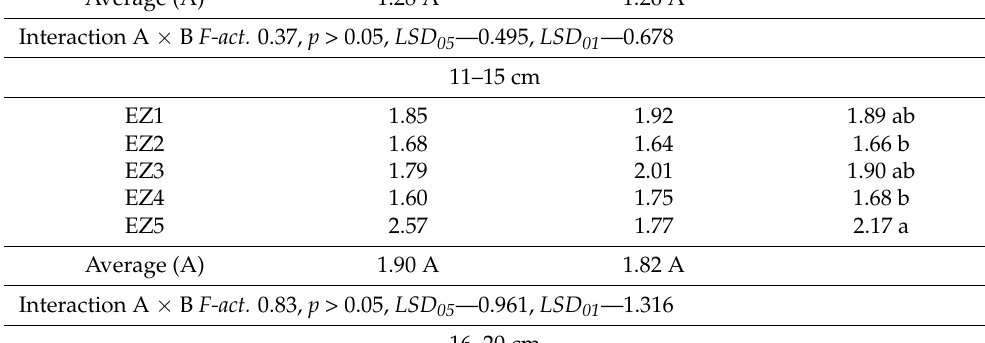
Treatment (A) Uniform